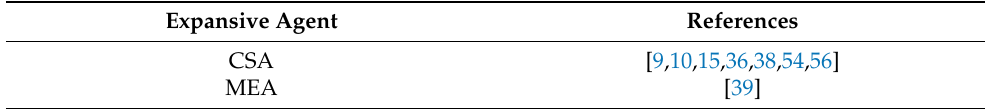
Table 9. Case of specimens mixed with CA and expansive agent. Expansive